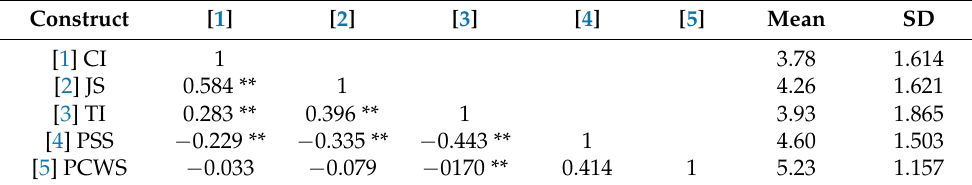
Table 3. Correlations and descriptive